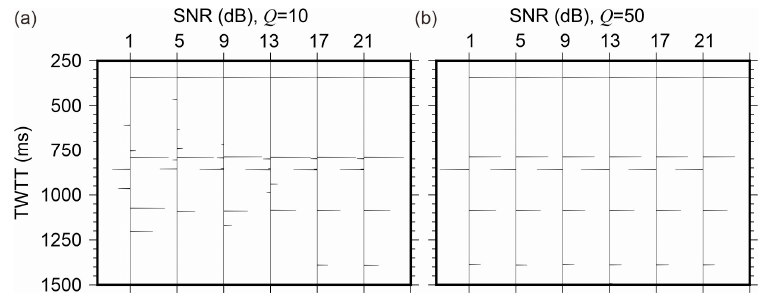
9 of 21 Figure 4. Seismograms obtained by ITD inversion of the data in Figure 3: ( a ) model with Q = 10, ( b ) Q = 50. The curve below each graph is the logarithm of the residual energy defined by Equation (12). For weaker attenuation with Q = 50, inverse- Q filtering recovered the first four reflec- tions at almost all SNRs. However, at low SNR levels, the inverse- Q filter still over-ampli- fied the noise (for example, for SNR < 13 dB). By contrast, the ITD not only recovered the reflections but also filtered out the noise, which helped improve the images (Figure 4b). The residual data error ε (N) below each graph in Figure 4 showed a decreasing trend with increasing SNR levels but did not depend on Q . For low SNR levels, the increased ε ( N ) values were due to two factors: biases in measuring reflectivity amplitudes and